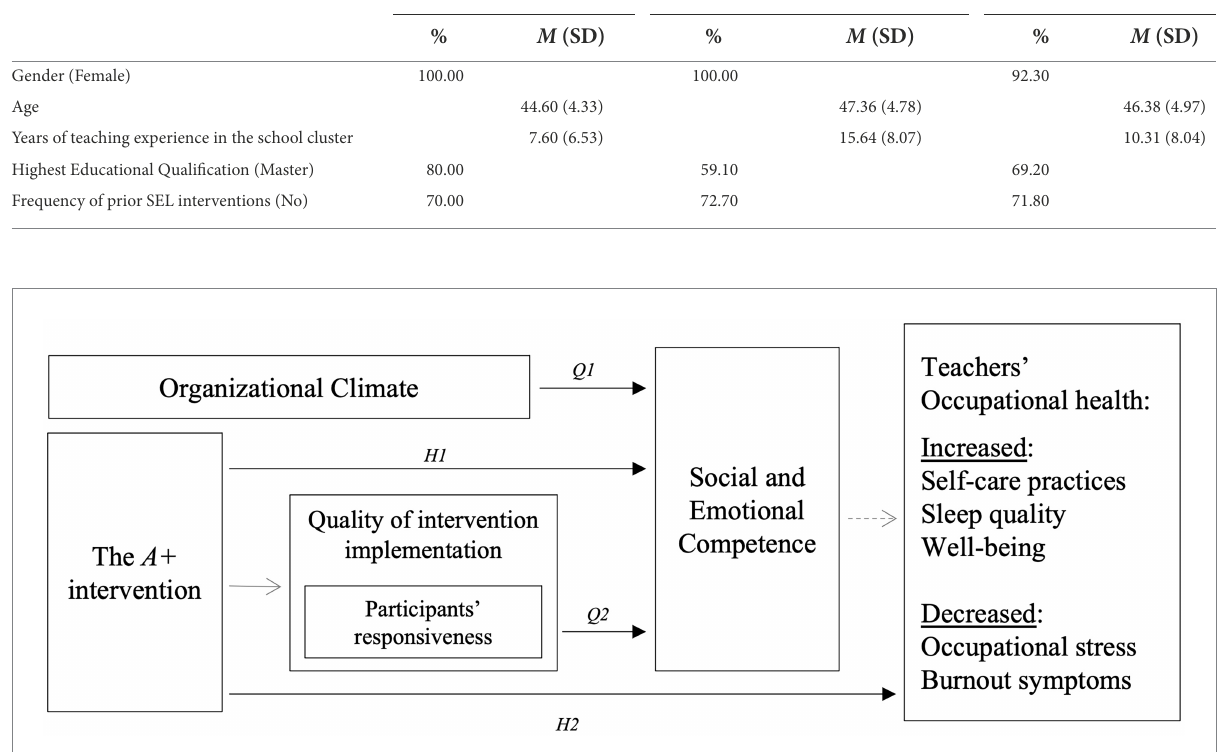
FIGURE 1 The proposed conceptual model of relationships between study variables. Due to sample size limitations, despite theoretically sustained, mediation analysis was not tested in this